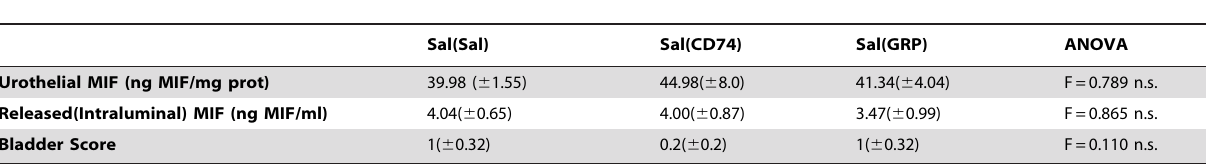
Table 2. Mean and S.E.M for each parameter in control groups (N=